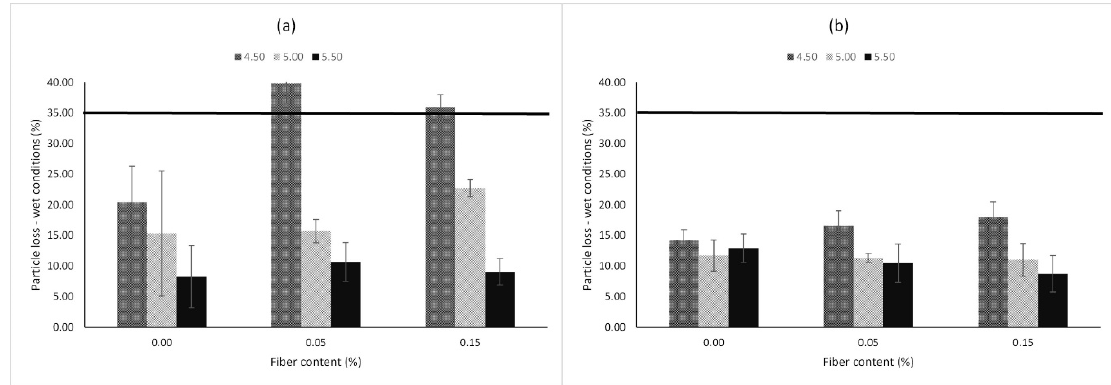
Figure 9. Particle loss in wet conditions of PA mixtures. ( a ) Limestone. ( b ) Mixed filler.